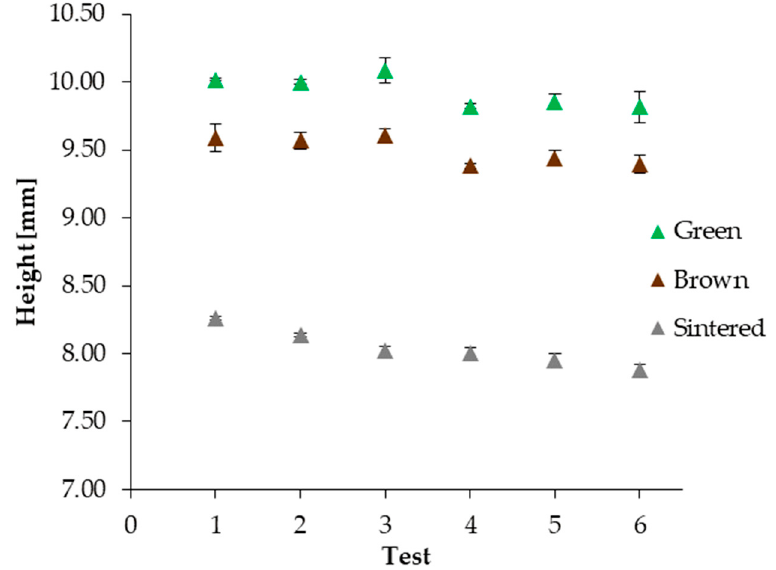
Figure 8. Height dimension evolution.